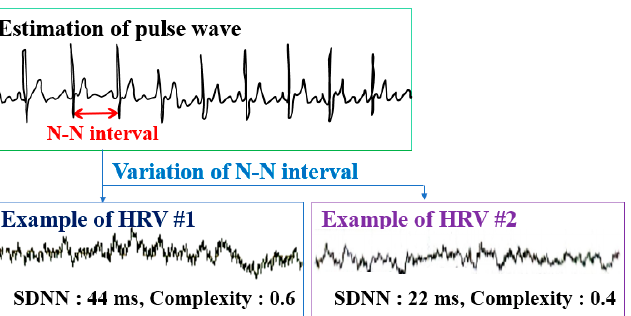
Figure 1. Determination of cumulative fatigue by heart rate variability (HRV) analysis.